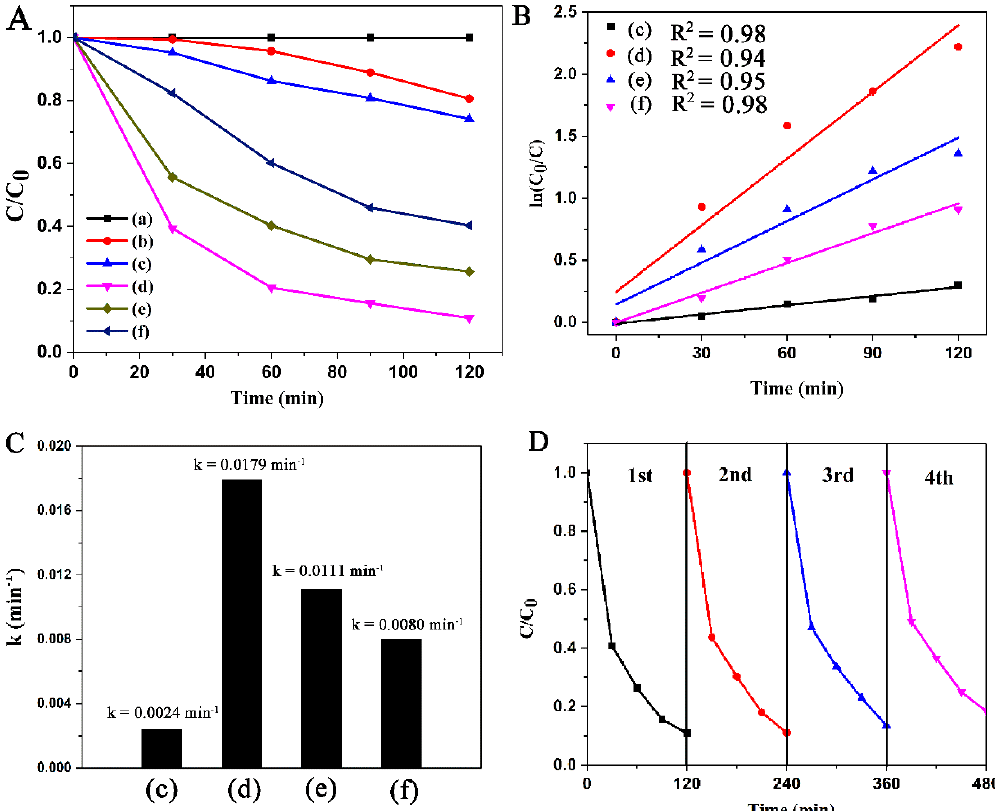
Figure 4. ( A ) Photocatalytic performances of different samples, ( B ) kinetic curves of the as-prepared samples, ( C ) rate constant k of the samples: (a) P-25, (b) α -Fe 2 O 3 , (c) g-C 3 N 4 , (d) 5 wt.% α -Fe 2 O 3 @g-C 3 N 4 photocatalyst, (e) 10 wt.% α -Fe 2 O 3 @g-C 3 N 4 photocatalyst, (f) 20 wt.%